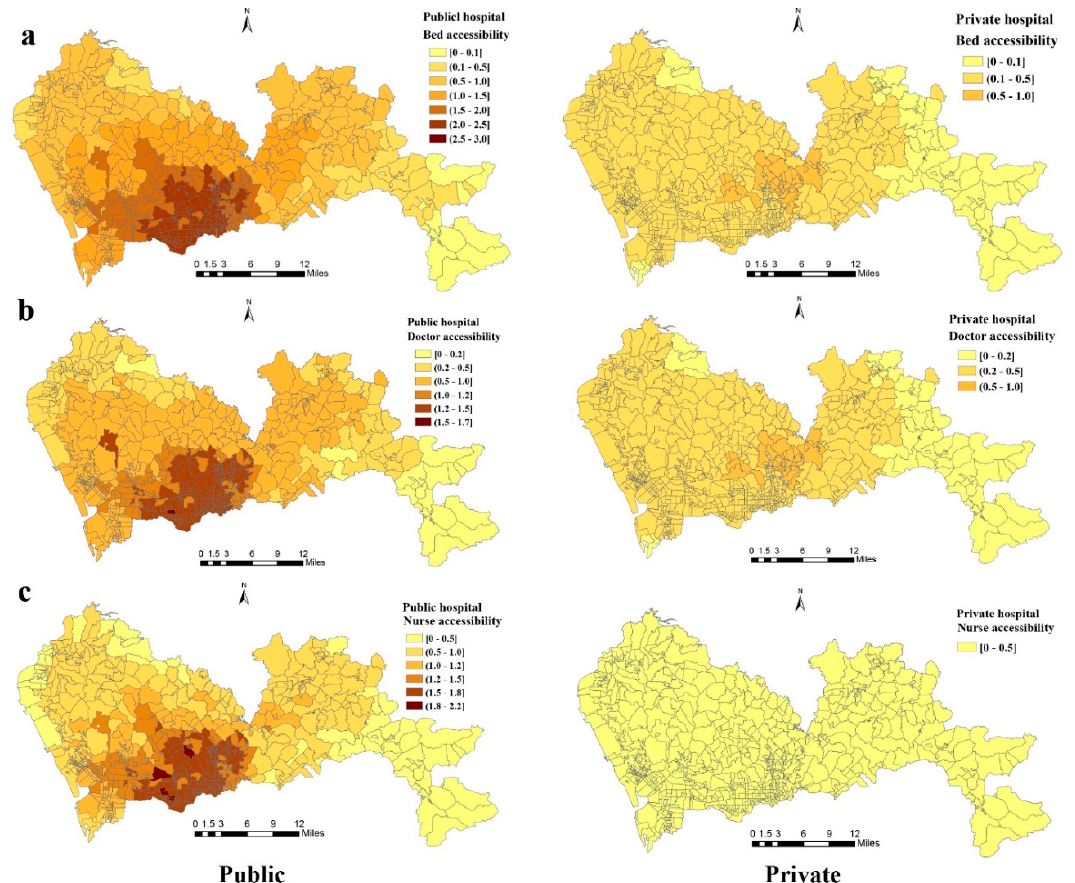
Figure 5. Spatial accessibility of ( a ) beds, ( b ) doctors, and ( c ) nurses in public and private hospitals calculated using the E2SFCA method.